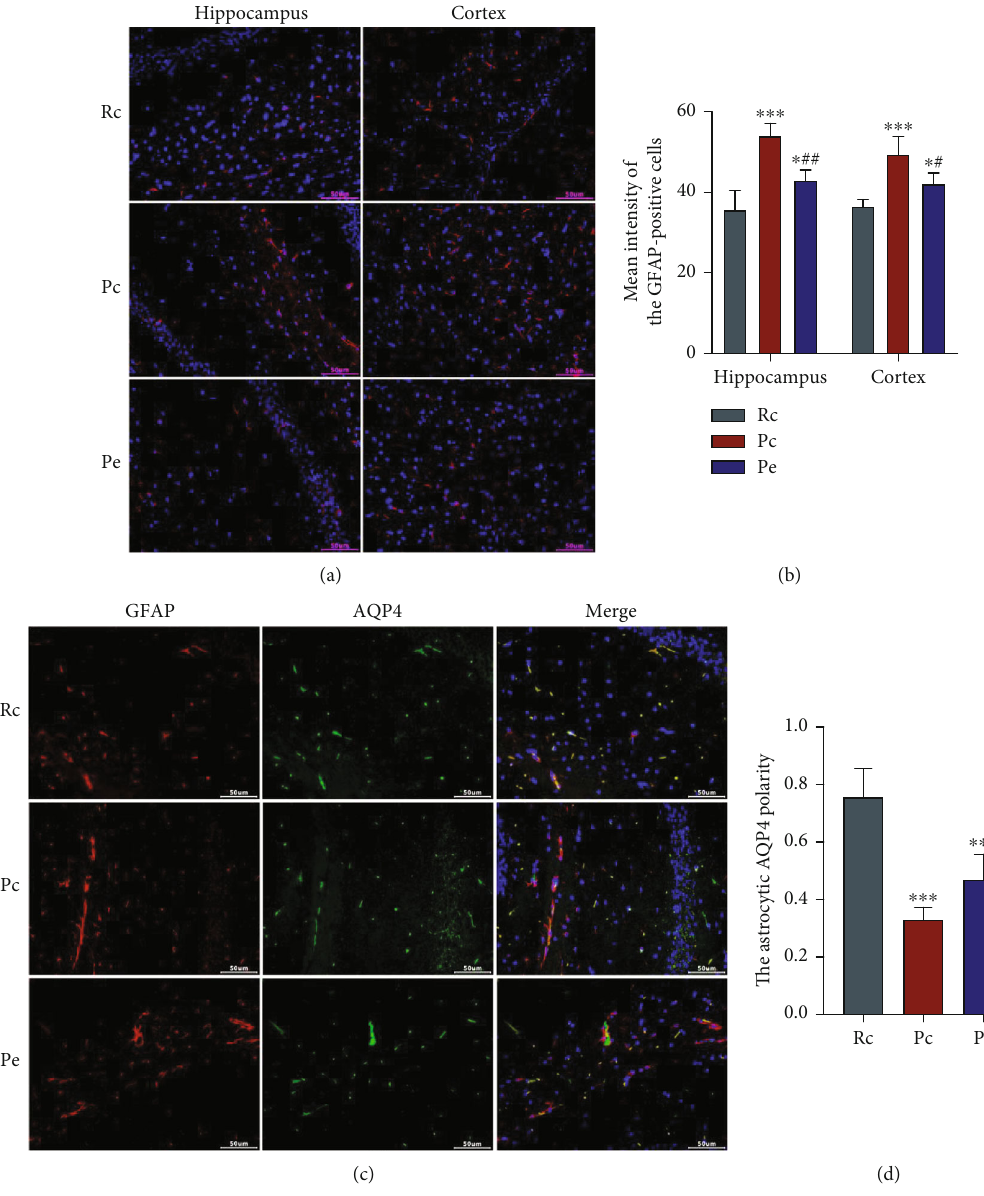
Figure 7: EA inhibited the reactivity of astrocytes and improved AQP4 polarity. (a) GFAP-positive cells were spread in each group, scale bars = 50 μ m. (b) The mean fl uorescence intensity of GFAP-positive cells in the hippocampus and cortex. (c) Immuno fl uorescence: double-labeling of GFAP and AQP4, scale bars = 50 μ m. (d) Astrocytic AQP4 polarity. Data are expressed as the mean ± SD ( n = 4 in each group). ∗ P < 0 : 05 , ∗∗ P < 0 : 01 , and ∗∗∗ P < 0 : 001 versus the Rc group; # P < 0 : 05 and ## P < 0 : 01 versus the Pc